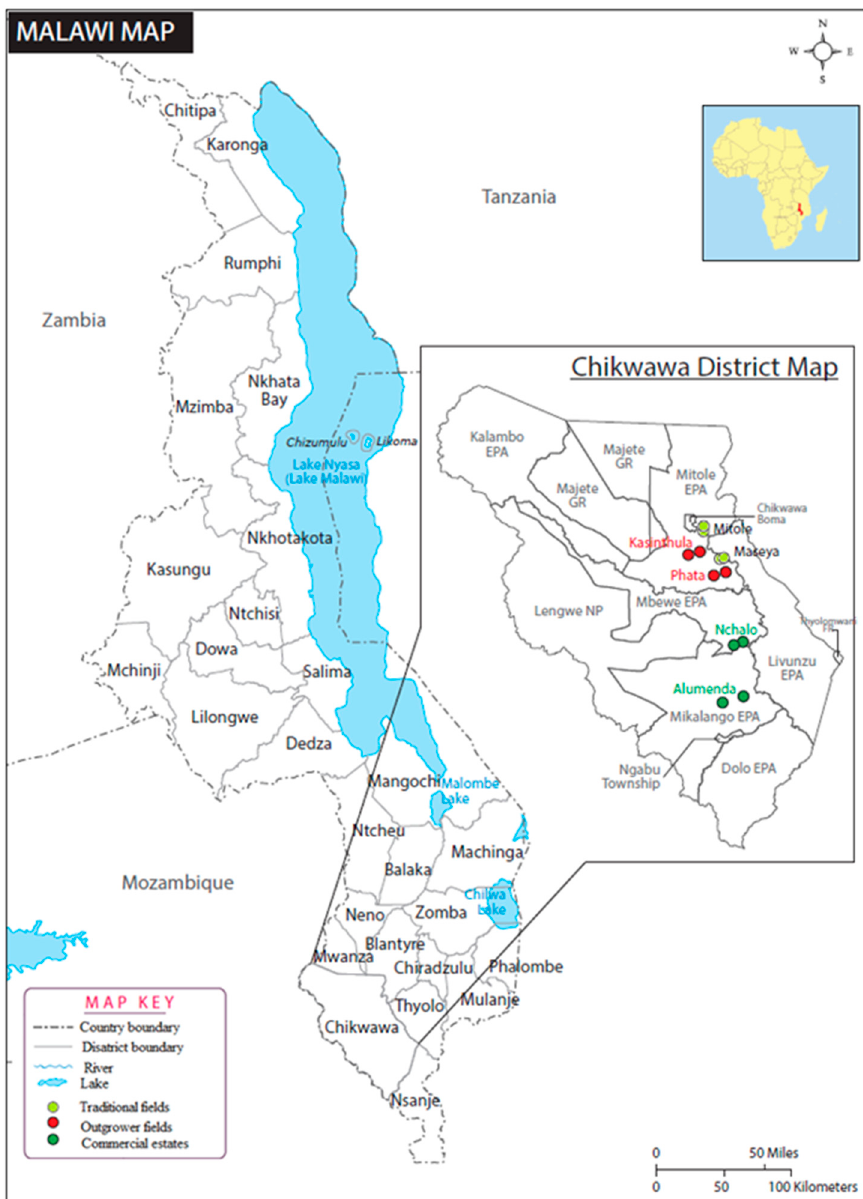
Figure 1. Locations of the 12 sugarcane fields sampled in Chikwawa District, southern Malawi.